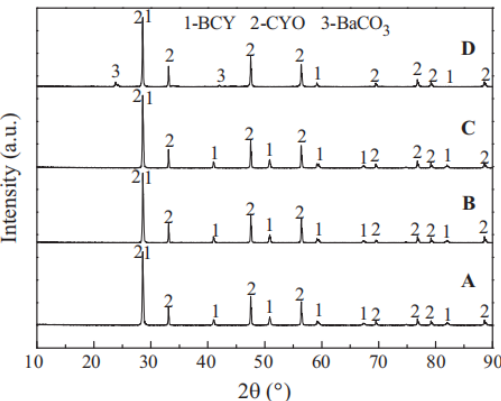
Figure 7. XRD patterns of BCY-CYO after the stability test in atmosphere containing 4% H 2 ( B ), H 2 O ( C ), 100% CO 2 ( D ); original membrane ( A ) [66]. Table 2. Cercer dual-phase membranes and the hydrogen-permeation performances. H 2 Flux Composition